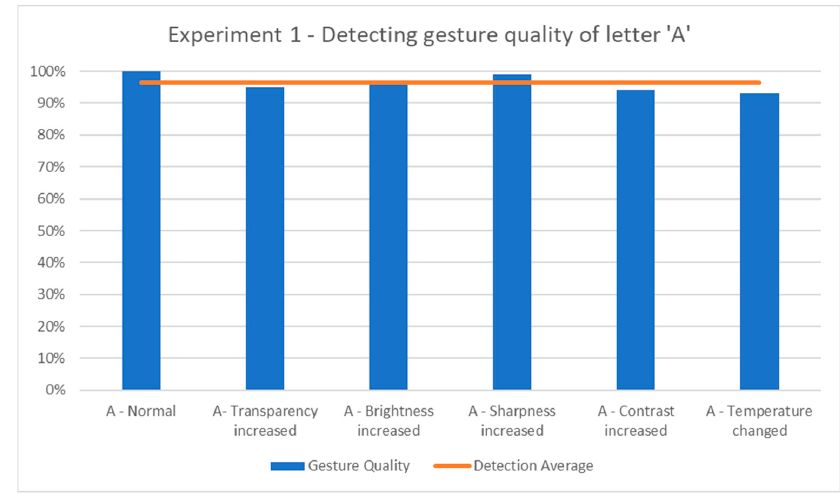
Figure 10. Quality detection accuracy of the algorithm.